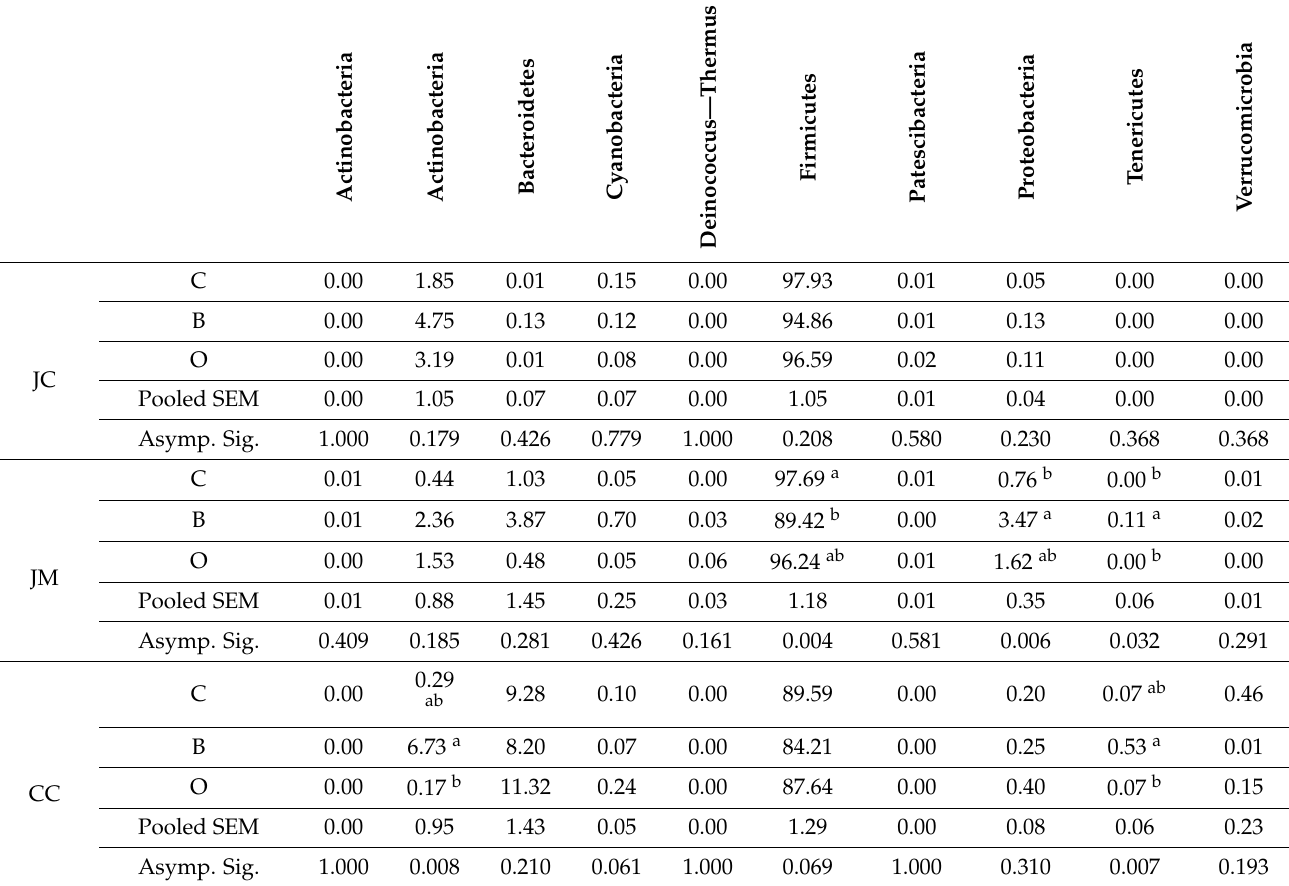
Table 6. Relative abundance of bacterial phyla in the different sampling places